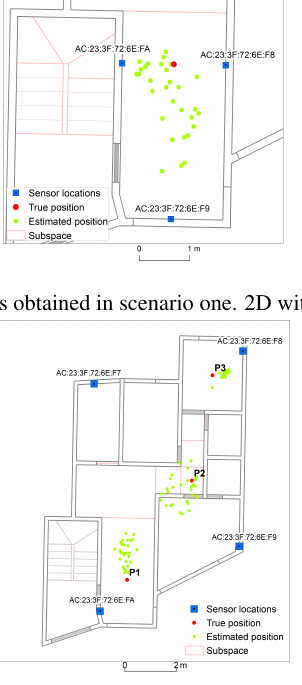
Figure 8. Results obtained in the second scenario. 2D with obstacles